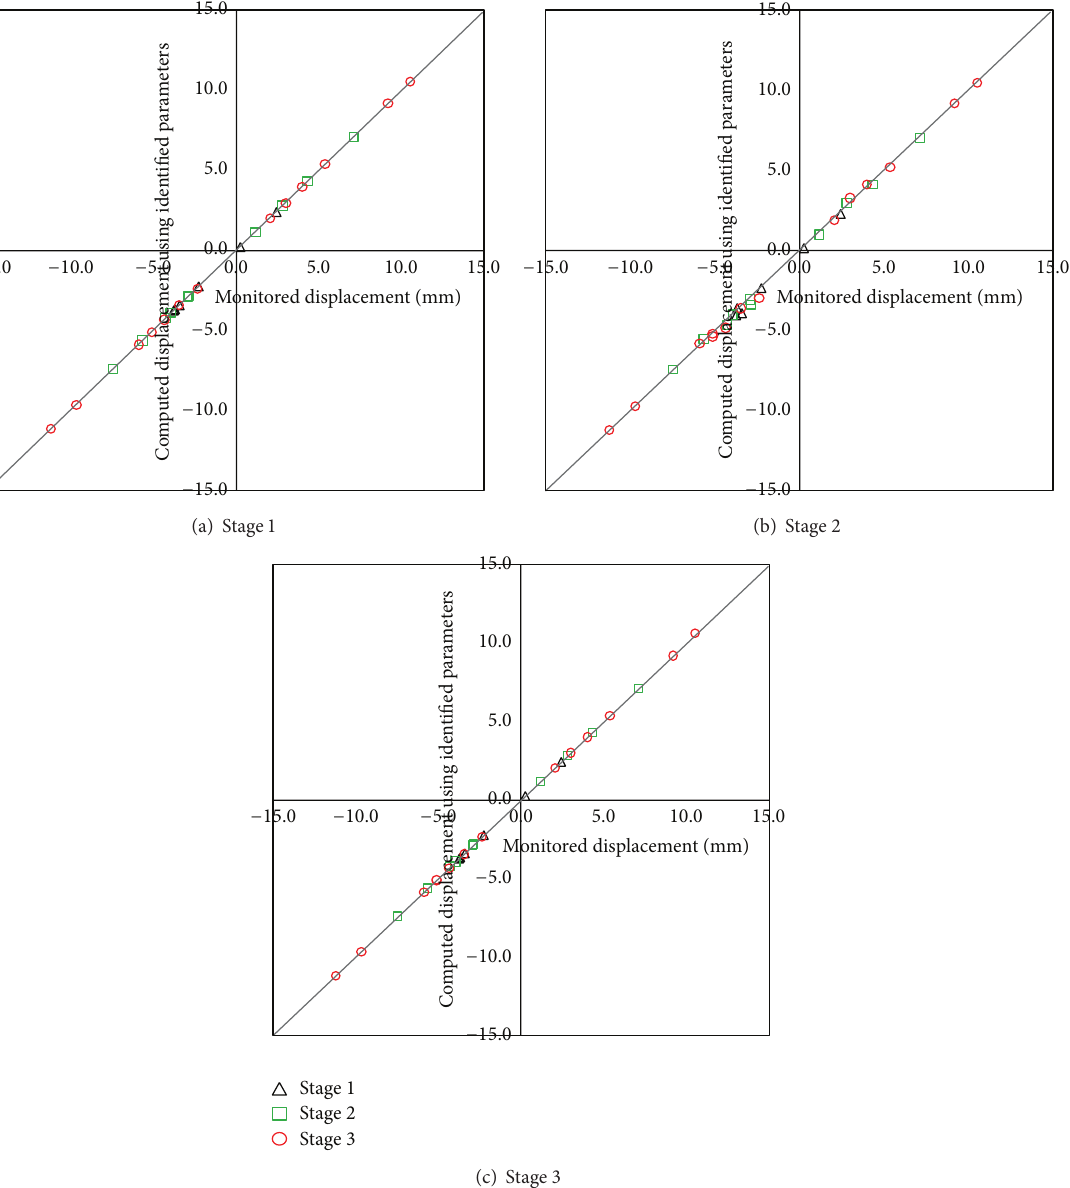
Figure 11: Comparison between monitored displacement and predicted displacement using identified